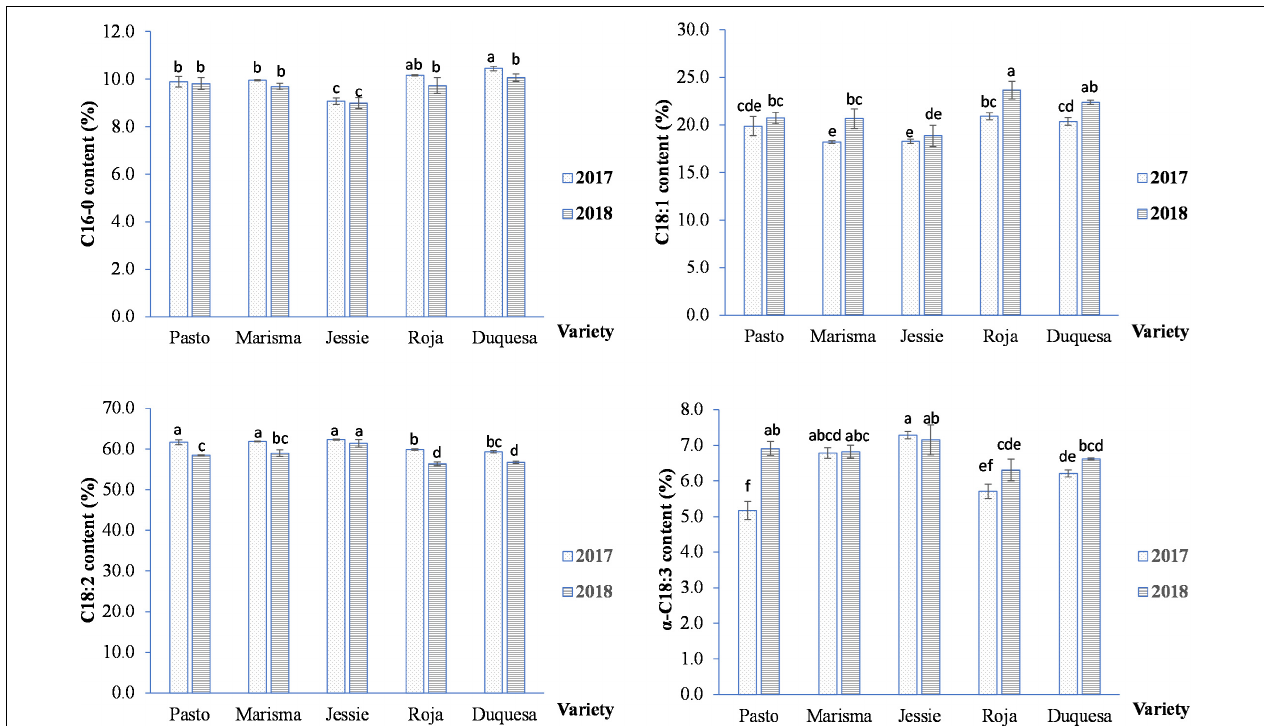
FIGURE 3 | Major fatty acid contents of quinoa seeds obtained from five varieties and 2 cultivation years (2017 and 2018). Error bars correspond to the SDs. Bars that do not share the same letters show statistically significant differences following an ANOVA test and Tukey’s post hoc test (C16:0, C18:1, C18:2, and α -C18:3) at a p -value <